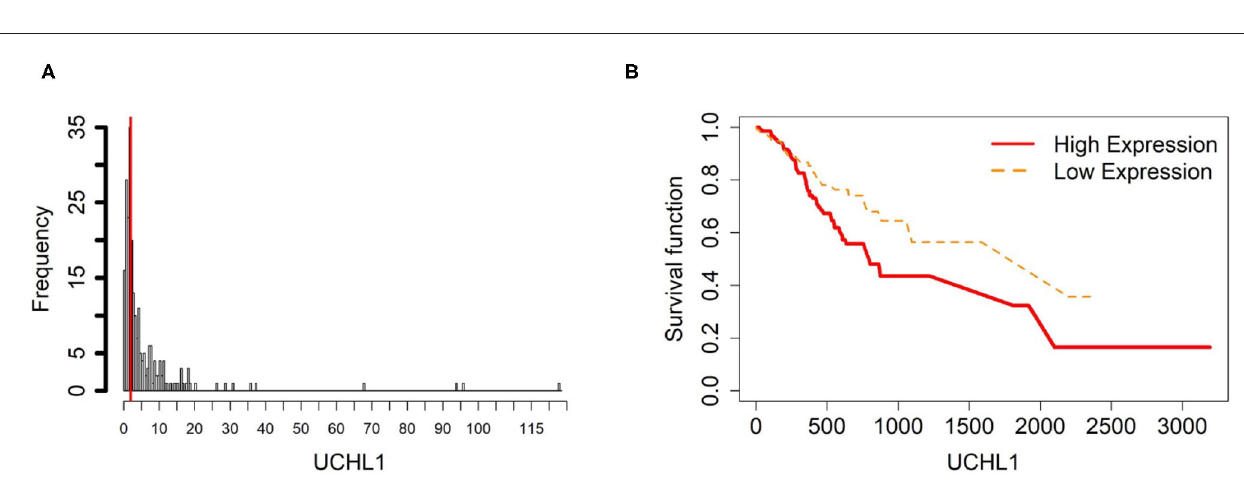
FIGURE 7 | Survival analysis in UCHL1. (A) Depicts the histogram of UCHL1 gene expression. From TCGA-STAD dataset, we set 2 as the gene expression threshold to separate the 238 observations into two groups: low expression and high expression groups of samples. (B) Shows the estimated survival function plots using a Cox proportional hazard regression analysis between the two groups; FDR p -value = 0.0325 indicates a significant survival time difference between the two groups.